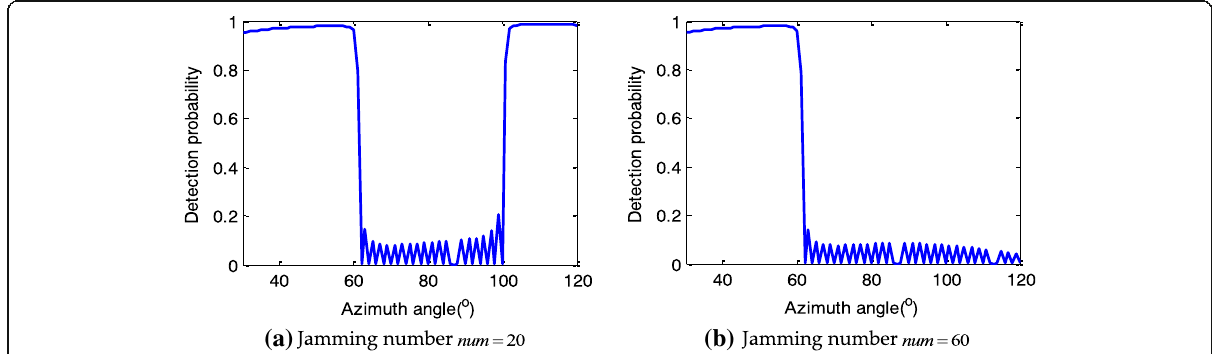
Fig. 13 Detection probability changes with different numbers of jammers. a Jamming number num = 20. b Jamming number num = 60